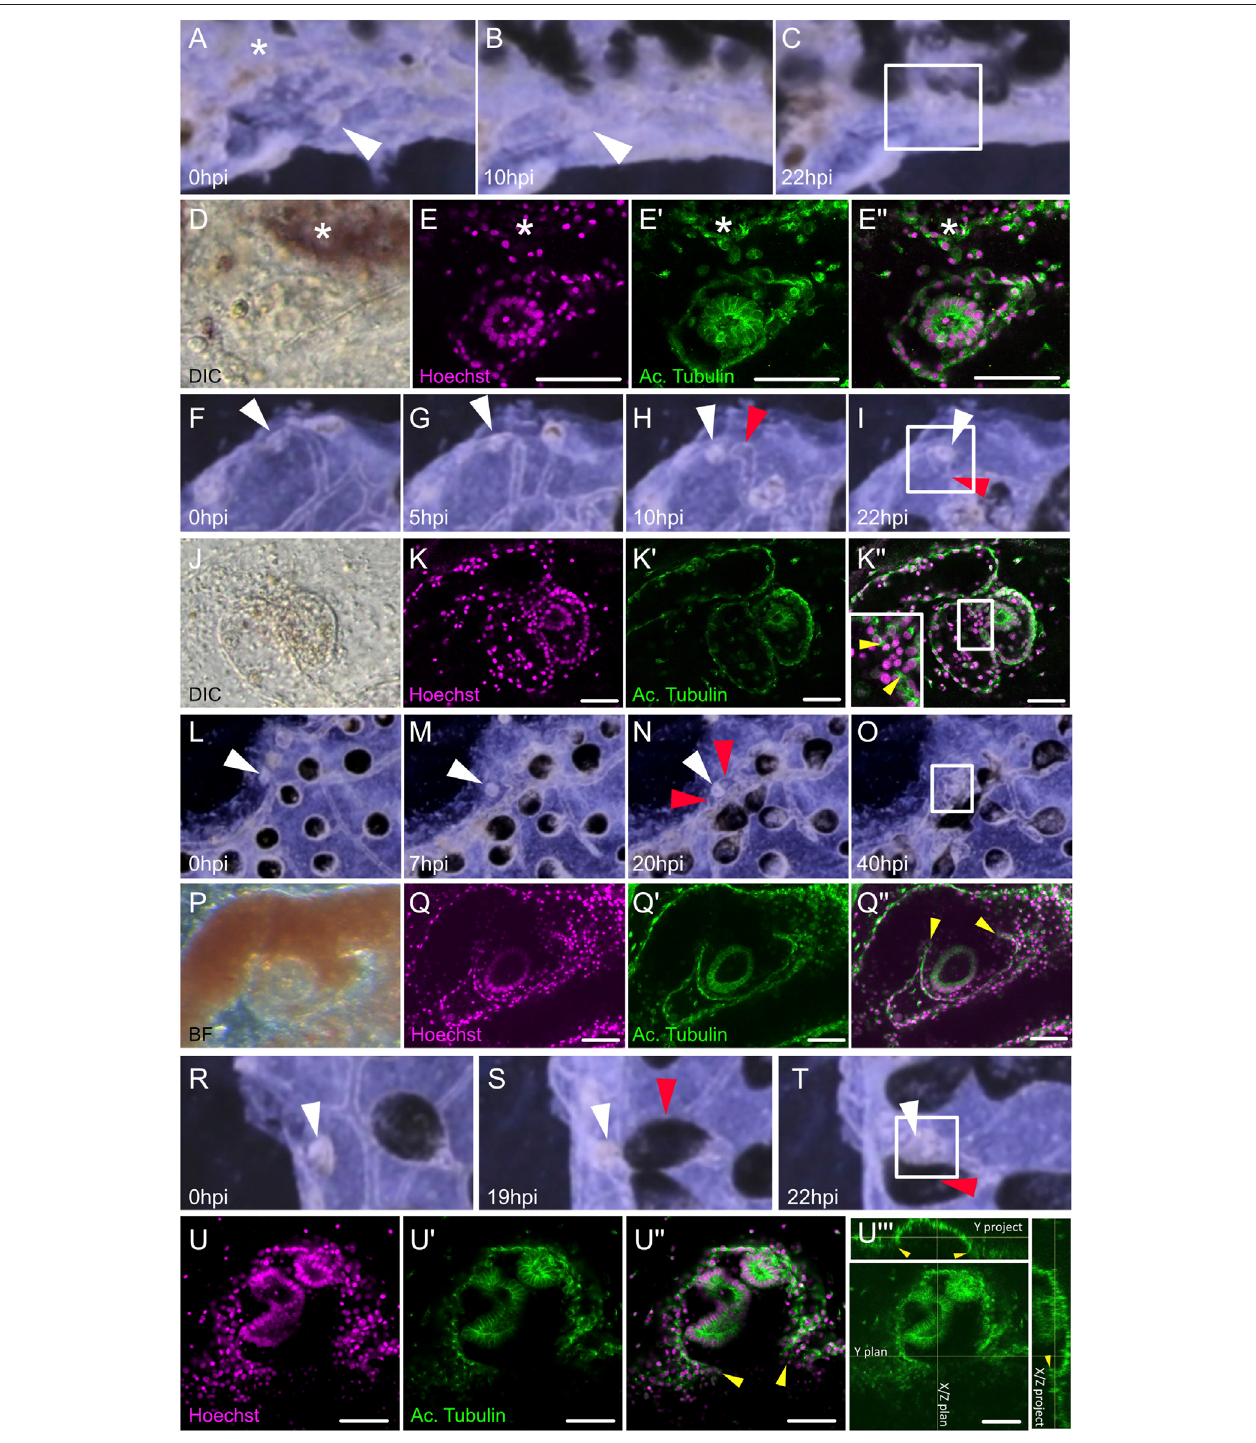
FIGURE2| Dynamic ofthemigration ofextravasculartissues intothevascularnetwork. (A – C) Screenshotsfrom Supplementary MovieS6 showtissue left-over gettinginclosecontacttothevasculaturefrom (A) 0 hpost-injury(hpi)to (B) 10 hpiand (C) 22 hpi. (D – E ’’ ) Microscopicviewoftheareassquaredin (C) . (D) Transmitted light with DIC fi lter, the double monolayer vesicle can be seen in the tunic. (E) Hoechst staining. (E 9 ) Acetylated tubulin counter-staining. (E ’’ ) Composite. (F – I) Screenshotsfrom SupplementaryMovieS7 showingtissueleft-overfusingwiththevasculatureatthedoublevesiclestage,from (F) 0 hpito (G) 5 hpi, (H) 10 hpi, and (I) 22 hpi. (J – K ’’ ) Microscopicviewoftheareassquaredin (I) . (J) TransmittedlightwithDIC fi lter,thedoublemonolayervesiclecanbeseeninthetunic. (K) Hoechst staining. (K- 9 ) Acetylated tubulin counter-staining. (K ’’ ) Composite, the insert isamagni fi cation ofthe region offusion. (L – O) Screenshots from SupplementaryMovie